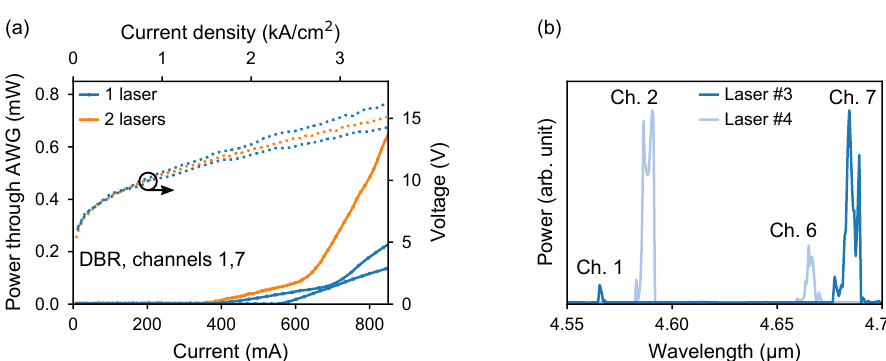
Figure 11. ( a ) LIV plots of a multi-spectral two-channel DBR while driving laser channels 1 and 7. ( b ) Spectra of the two-channel DBR laser (Laser #3) and another two-channel DFB laser (Laser #4).